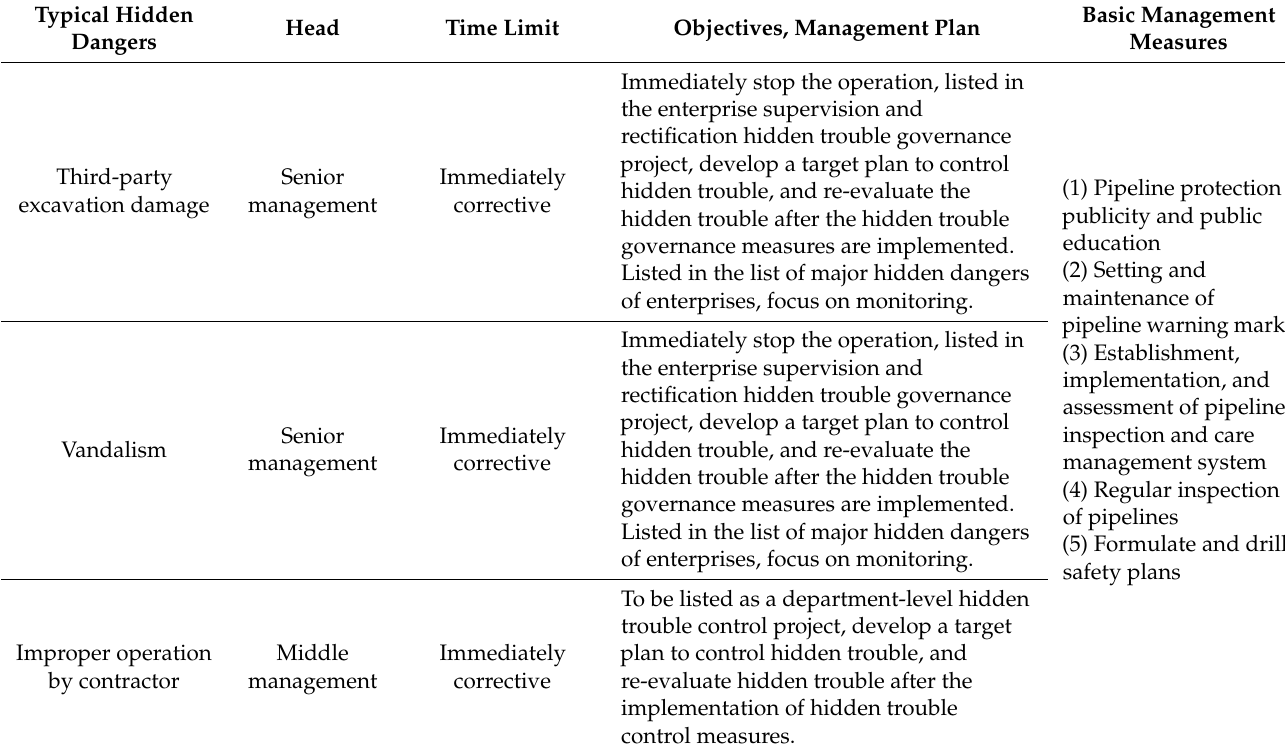
Table 13. Hidden danger classification disposal management scheme.